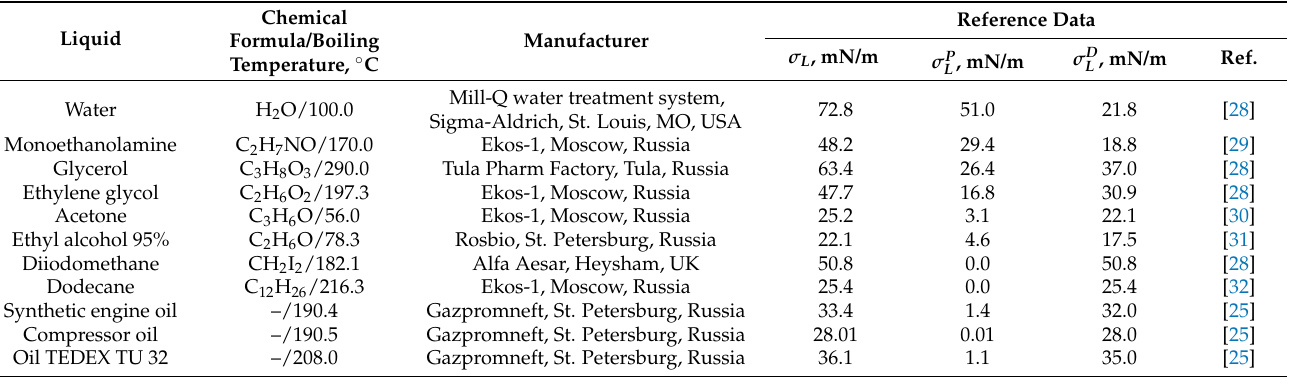
Table 1. Characteristics of components in composite